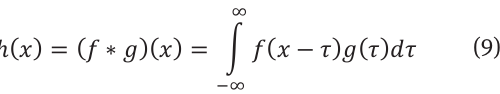
to detect because they are located exactly in point x